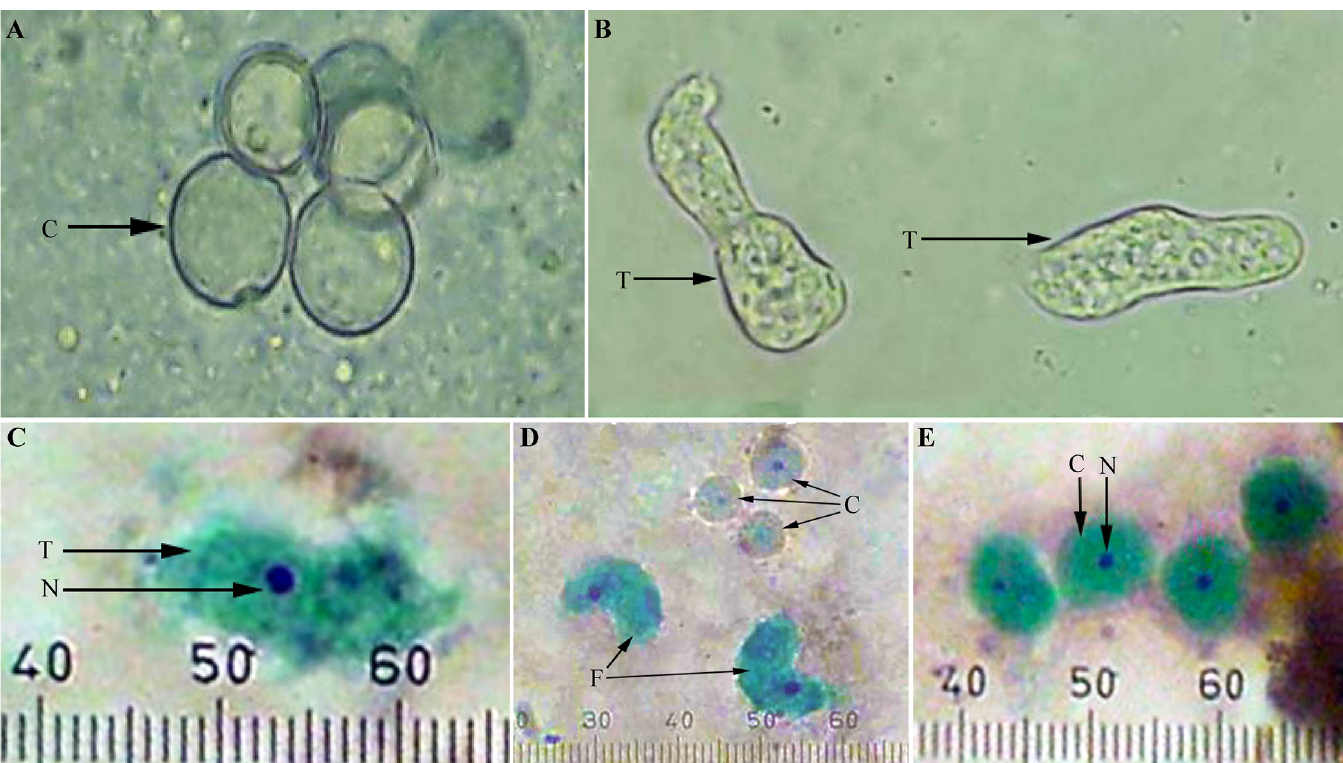
Fig 1. Naegleria cultures examined under the microscope. A : Naegleria cysts (without staining), arrow shows a cyst (C). B : Naegleria trophozoites (without staining), arrow shows a trophozoite (T) . C : Naegleria trophozoite (T) and the nucleus (N) in trichrome staining. D : Naegleria flagellates (F) and cysts (C) in trichrome staining. E : Naegleria cysts in trichrome staining show a cyst (C) and its nucleus (N).